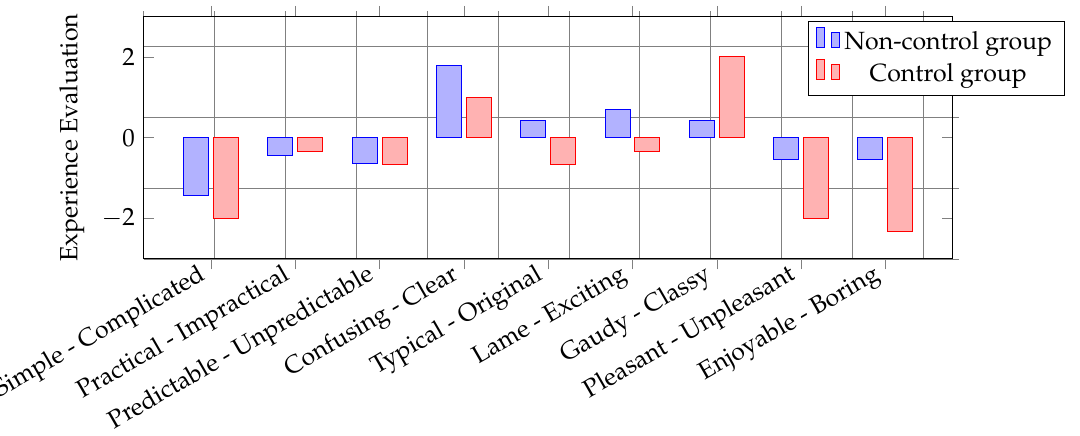
Figure 10. Mean values of AttrakDiff questionnaire responses, given by fifteen test-group (blue) and three control-group (red) participants (see Appendix